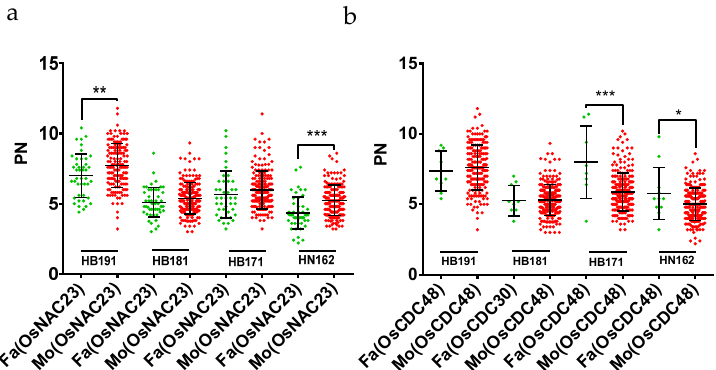
Figure 3. PN trait comparison of RILs with parental genotypes of two known genes in multiple environments. ( a ) PN trait comparison of RILs with parental genotypes of OsNAC23 in multiple environments (HB191, HB181, HB171, HN162); ( b ) PN trait comparison of RILs with parental genotypes of OsCDC48 in multiple environments (HB191, HB181, HB171, HN162). RILs with the male parental genotype and female parental genotype of the OsNAC23 and OsCDC48 are marked by green dots and red dots in point clouds, respectively. * represents p < 0.05, ** represents p < 0.01, *** represents p < 0.001. PN: the effective panicle numbers per plant.